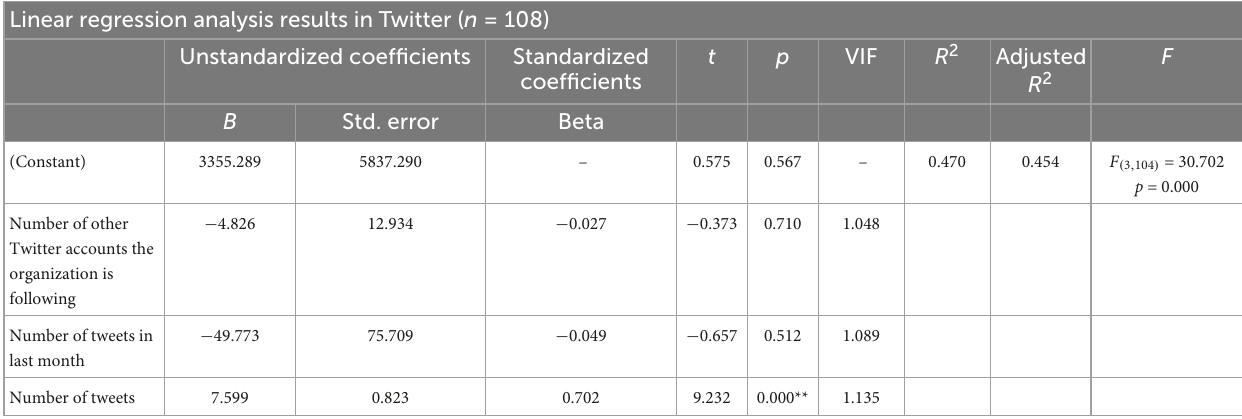
TABLE 4 Linear regression results of the effect of the number of tweets, number of tweets in the last month, and number of other Twitter accounts the organization is following on the number of Twitter followers of an organization. Linear regression analysis results in Twitter ( n = 108)